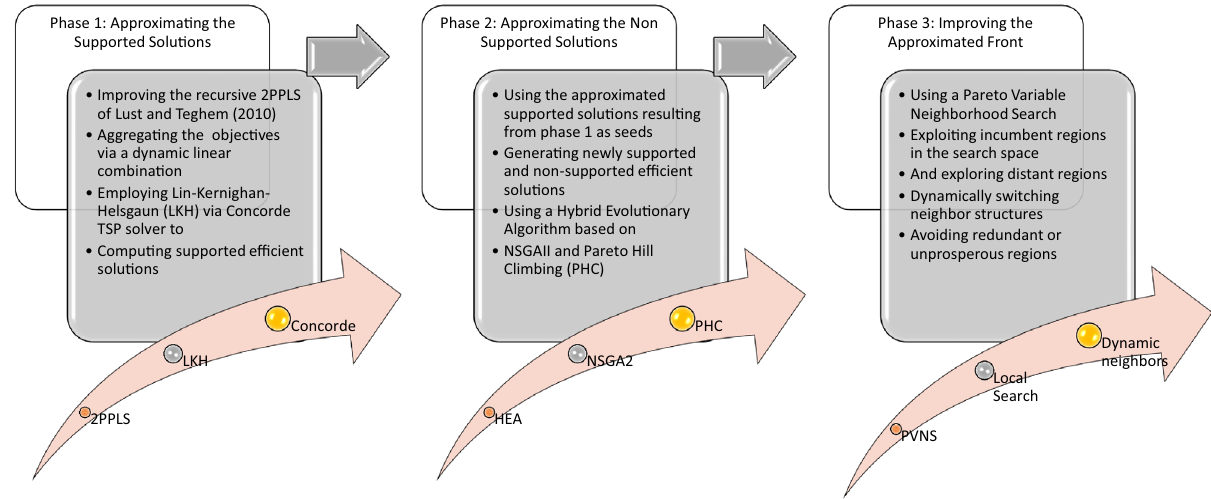
Figure 2. Illustration of the proposed method.